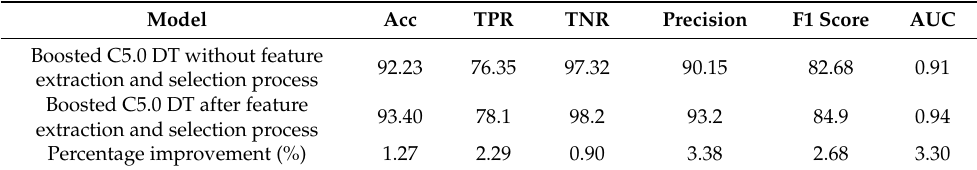
Table 9. Percentage improvement in Boosted C5.0 DT after proposed feature extraction and selection process.